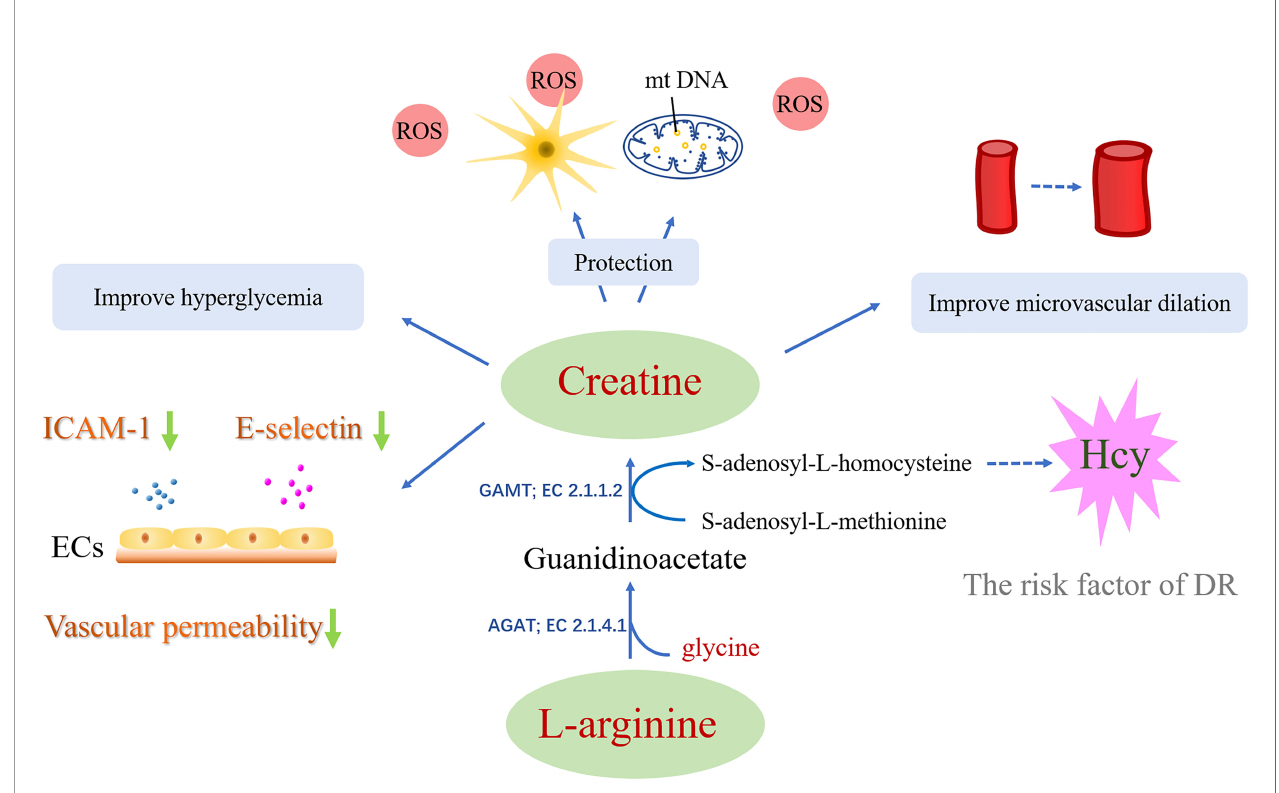
FIGURE 4 | The approach of creatine in treating diabetic retinopathy: i) Creatine has the potential to act as an anti-in fl ammatory aid and provide vascular protection. ii) Creatine has a signi fi cant antioxidant effect and protects mtDNA and nerve cells from cytotoxicity induced by oxidative stress. iii) Creatine may help increase the bioavailability of epoxyeicosatrienoic acid, thereby improving microvascular dilation. iv) Creatine may reduce the formation of Hcy. v) Creatine supplementation can help improve